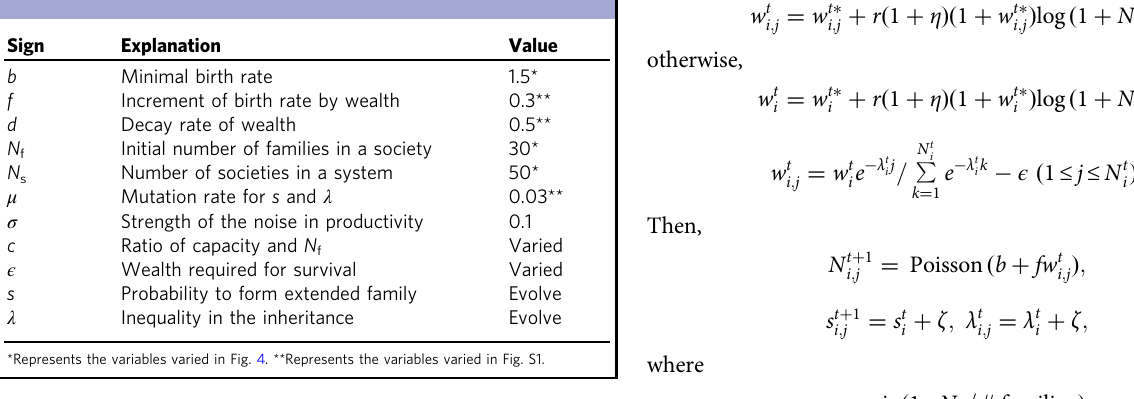
Table 1 Parameters used in the